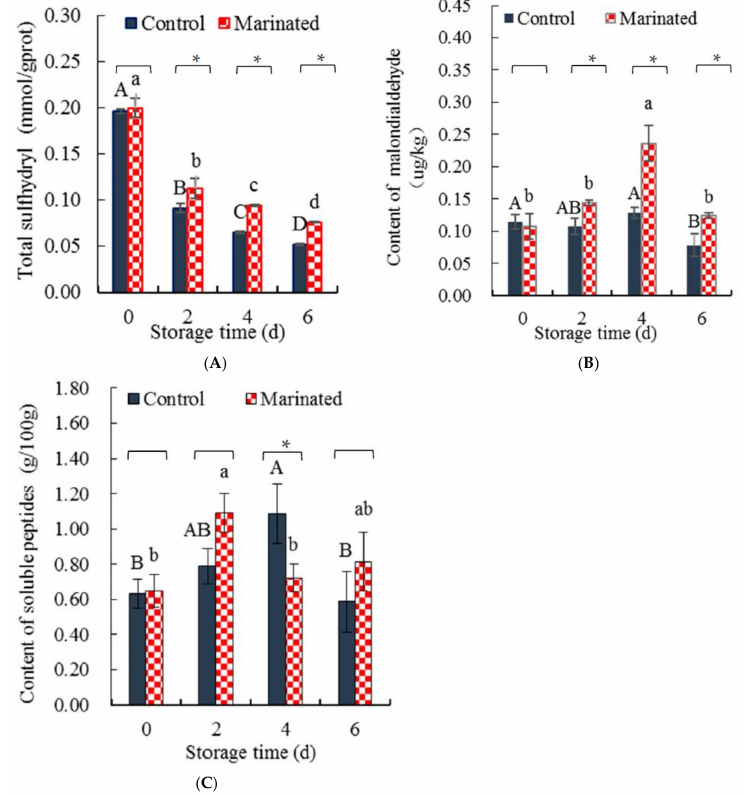
Figure 2. The content of sulfhydryl groups ( A ), MDA ( B ), and soluble peptide ( C ) in the marinated pork and the control. Values are presented as mean ± standard deviation. Different letters above the bars highlighting the standard deviations indicate significant differences ( p < 0.05). The asterisk indicates significant differences ( p < 0.05) between treatments for each